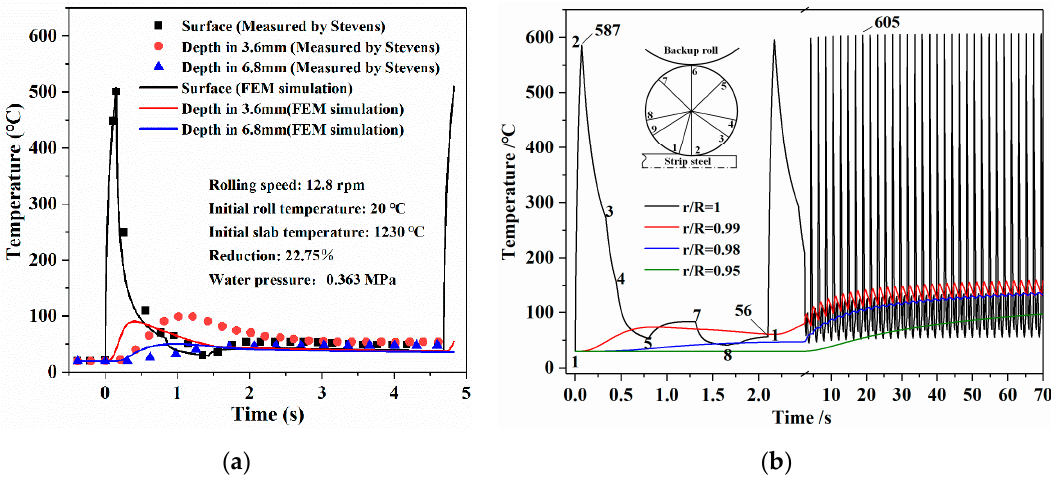
Figure 4. Temperature histories in the work roll during hot rolling: ( a ) comparison of temperature between the simulated results and the measured results (data from [28]); ( b ) temperatures with the different depths from the roll surface during the first strip rolling process.